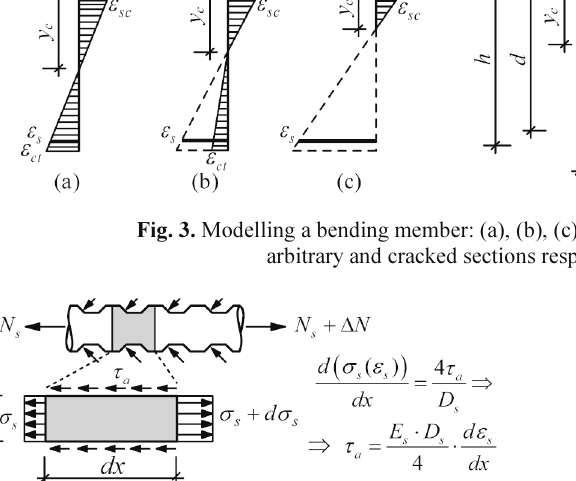
Fig. 4. Force equilibrium of a reinforcing bar